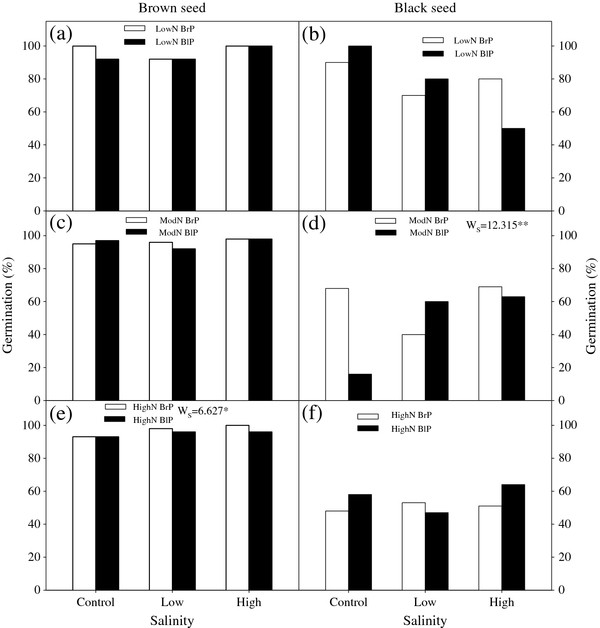
Effects of plant type and maternal salinity on germination of brown and black seeds for different nutrient availabilities. (a, b) Low nutrient, (c, d) Moderate nutrient, (e, f) High nutrient. N: Nutrient; BrP: Plant grown from brown seed; BlP: Plant grown from black seed. W-values are given when significance levels are reached (S: salinity; * P < 0.05, ** P < 0.01).